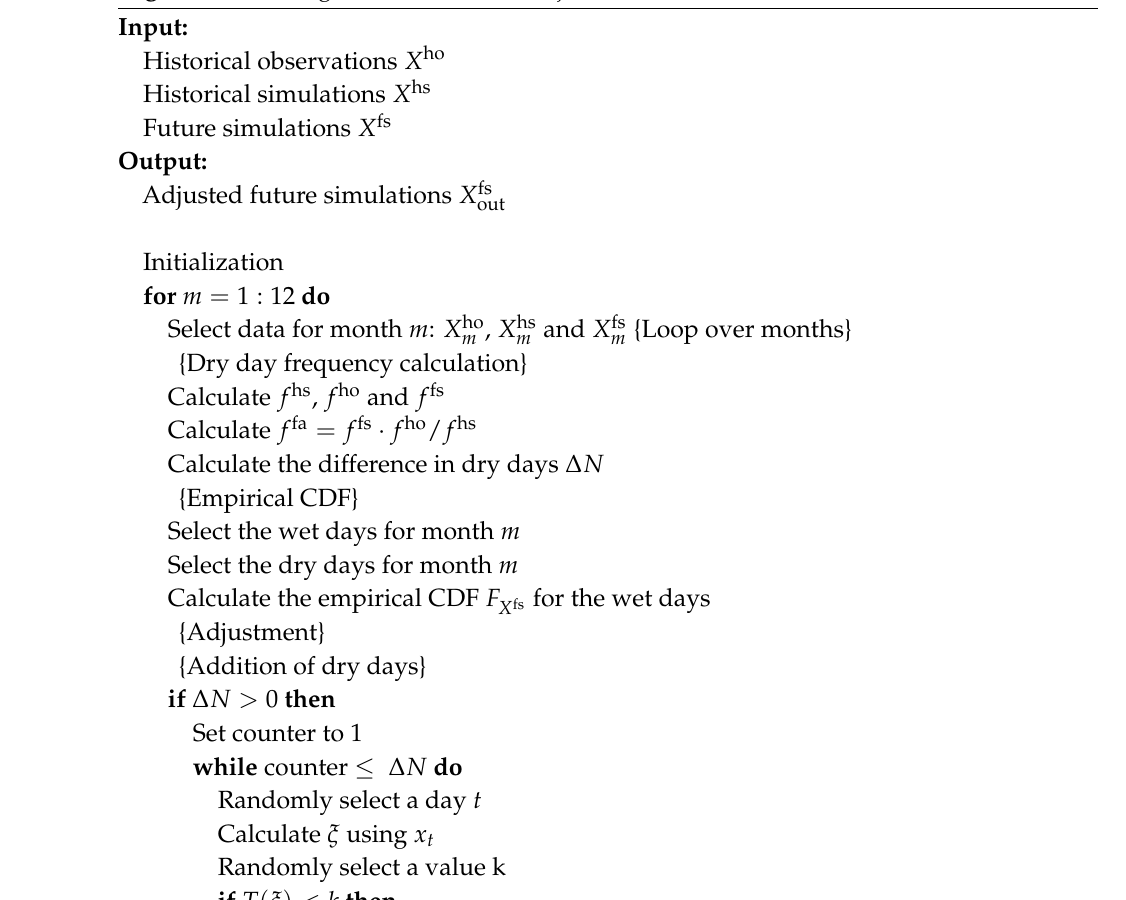
Algorithm 2 Triangular Distribution